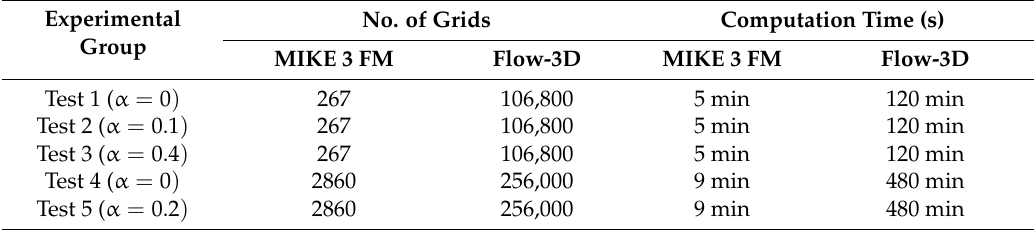
Table 5. The required computational time for the two models to address dam break flows in all